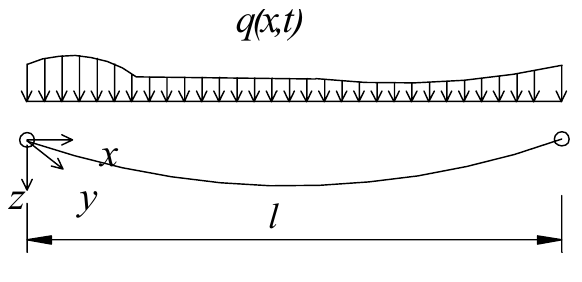
Fig. 1. Model of a suspended